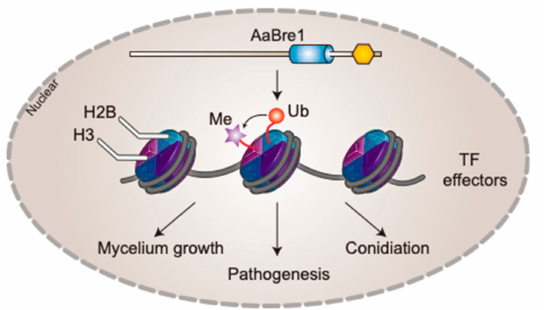
Figure 10. A proposed model of genetic networks regulated by AaBre1-mediated H2B monoubiquitination in A. alternata